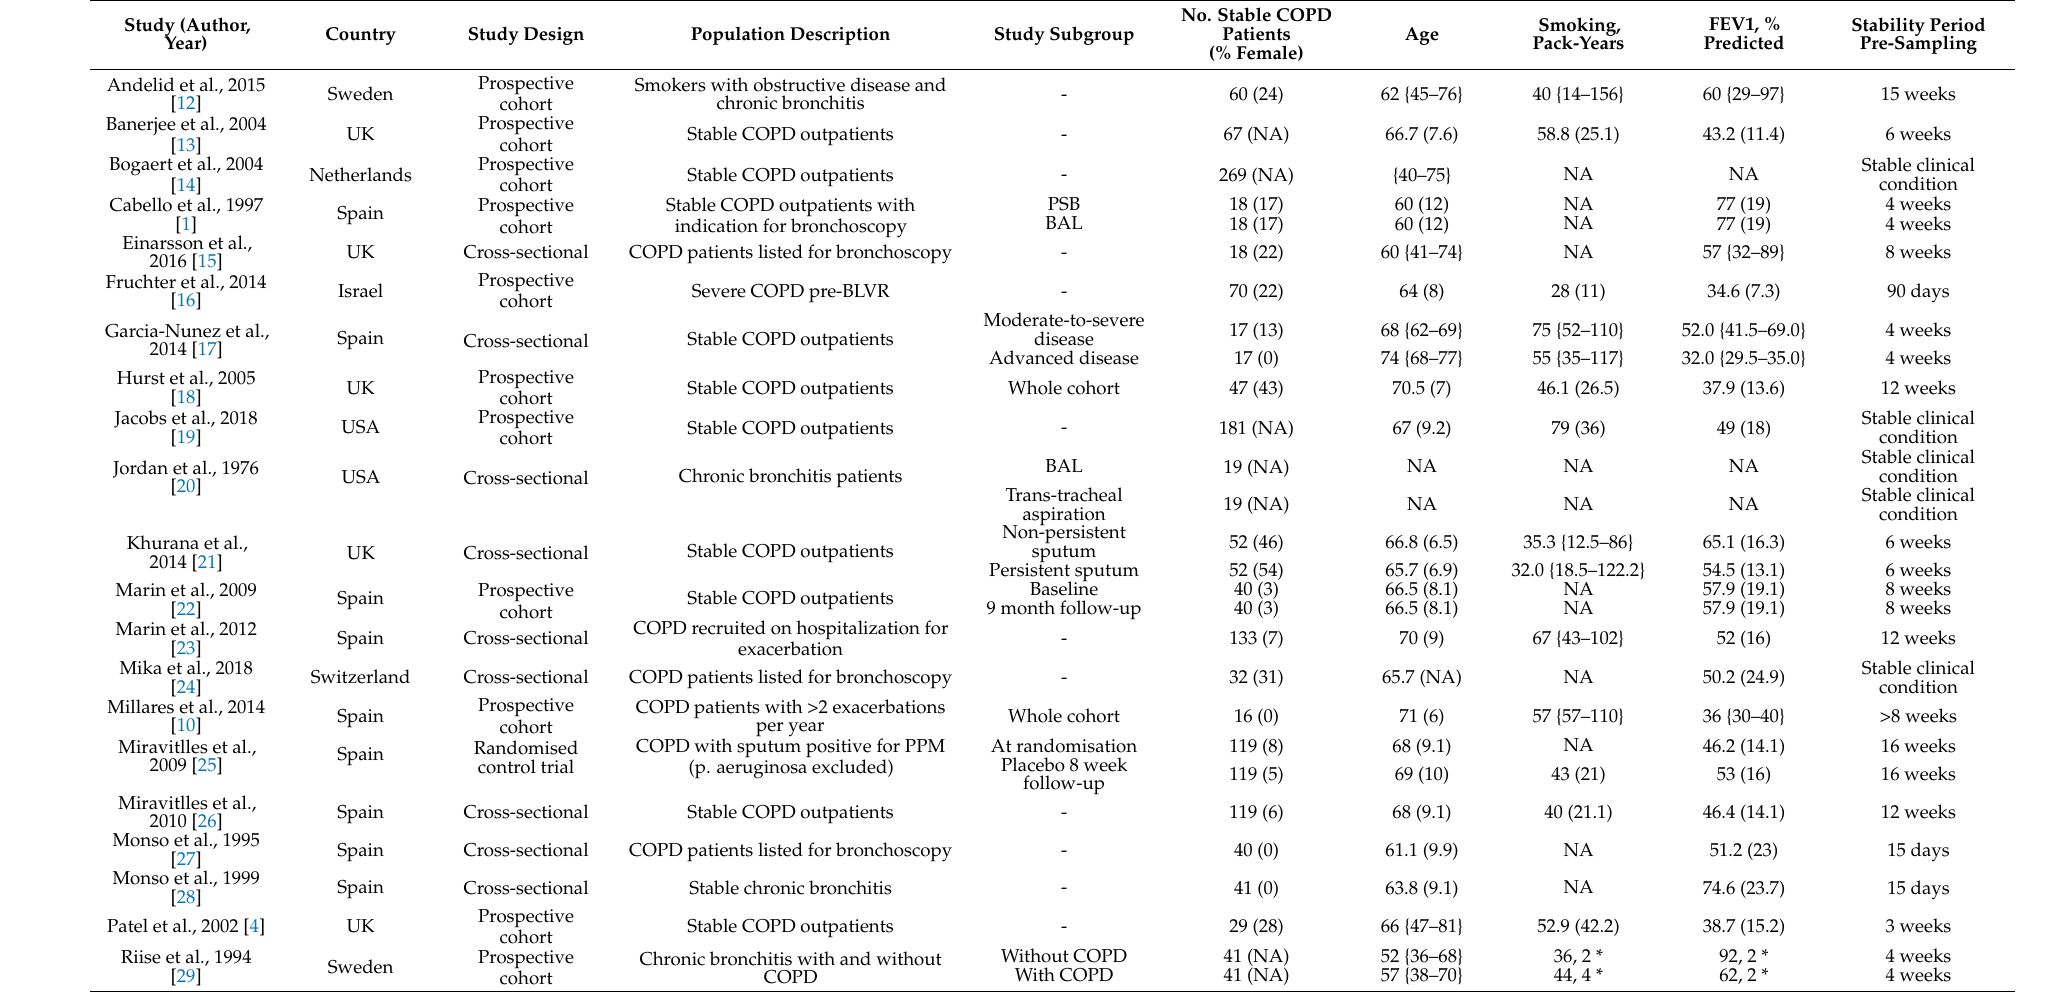
Table 2. Study characteristics and population